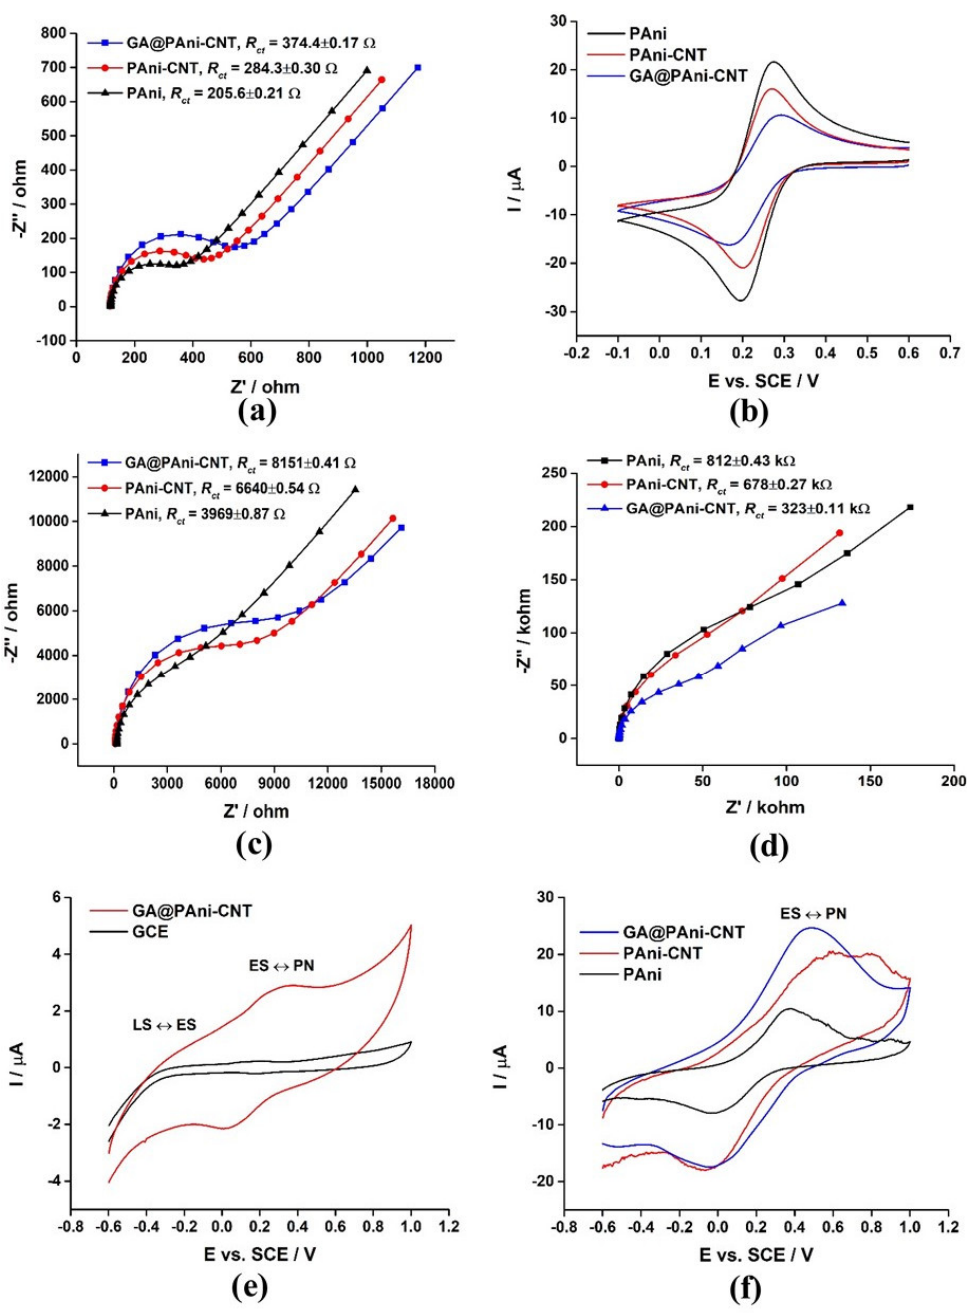
Figure 3. ( a ) EIS spectra and CV curves of PAni, PAni-CNT, and GA@PAni-CNT against 2 mM [Fe(CN) 6 ] 3 − /4 − in 0.1 M KCl ( a , b ), EIS spectra of the same in ( c ) 0.1 M pH 7 phosphate buffer and ( d ) 0.1 M pH 5 phosphate buffer containing 40 µ M NO 3 − , ( e ) CV curves of bare GCE in 0.1 M pH 5 phosphate containing 40 µ M NO 3 − and GA@PAni-CNT in 0.1 M pH 5 phosphate buffer, and ( f ) CV comparison in 0.1 M pH 5 phosphate containing 40 µ M NO 3 − .